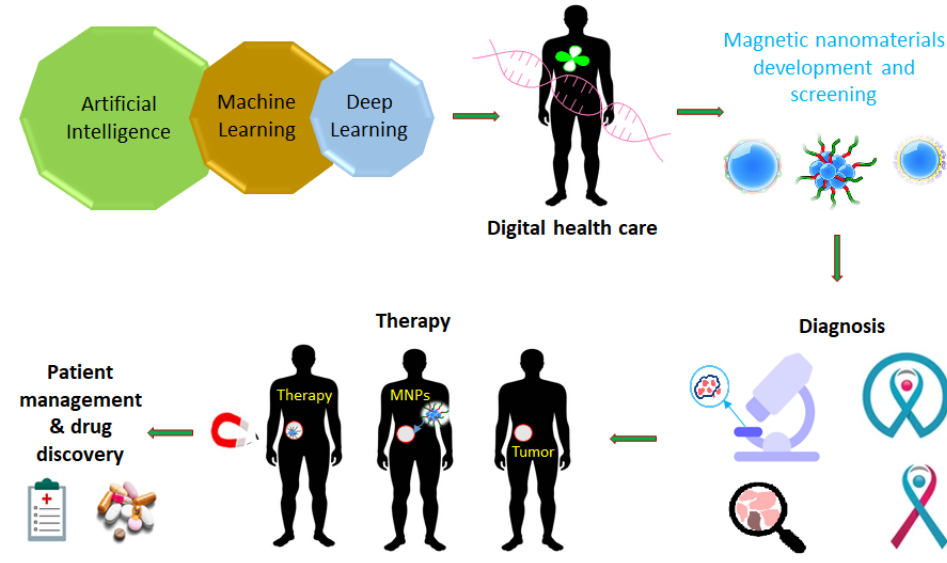
Figure 13. Schematic visualization of artificial intelligence in the precise diagnosis and treatment of liver cancer.